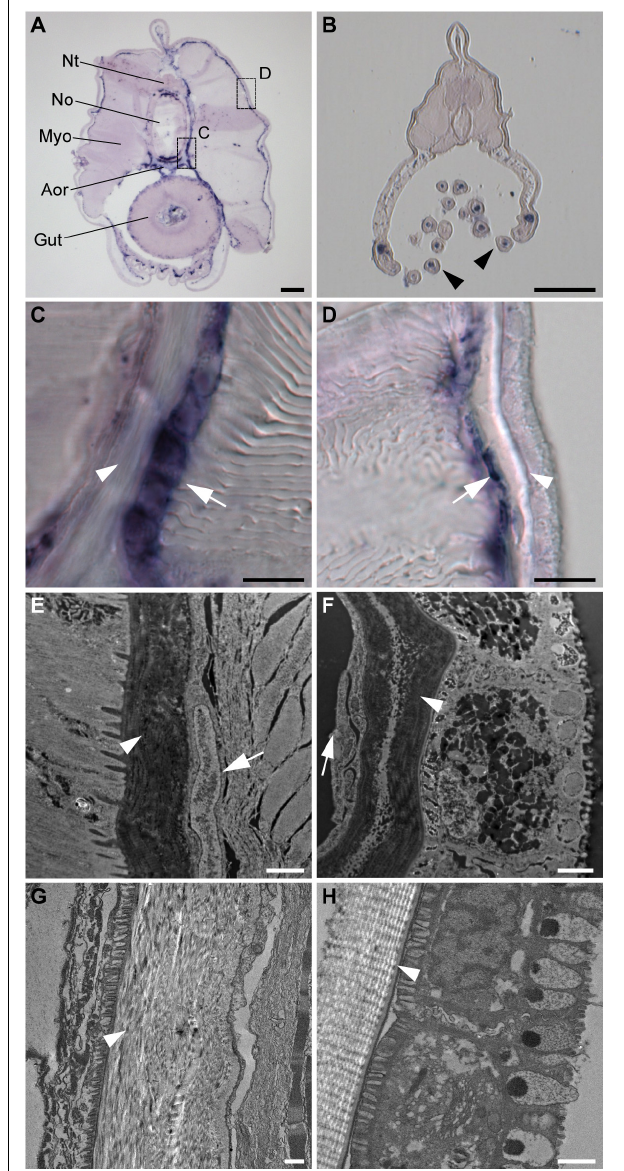
FIGURE 3 | Amphioxus SPARC is expressed in the mesothelial layer during advanced developmental stages. (A) Cross section of a juvenile amphioxus. Nt, Neural tube; No, Notochord; Aor, Aorta; Myo, Myotome; Scale bar, 50 µ m. (B) Cross section of a juvenile amphioxus, taken near the rostral region. Black arrowheads mark oral tentacles. Scale bar, 50 µ m. (C) Magnification of the area around the notochord region, indicated by the dashed box “c” in panel (A) . White arrows indicate the SPARC -expressing cells. White arrowhead indicates collagenous structures. Scale bar, 10 µ m. (D) Magnification of the area around the epidermal region indicated by the dashed box “d” in panel (A) . White arrows indicate SPARC -expressing cells. White arrowhead indicates collagenous structures. Scale bar, 10 µ m. (E,F) TEM images of (E) the notochord and (F) the epidermis of a young juvenile. White arrows indicate putative SPARC -expressing mesothelial cells. White arrowheads indicate collagenous structures. Scale bar, 1 µ m. (G,H) TEM images of (G) the notochordal sheath and (H) the epidermis of an older juvenile roughly corresponding to images (E) and (F) , respectively. White arrowheads mark collagenous structures. Scale bar, 1 µ